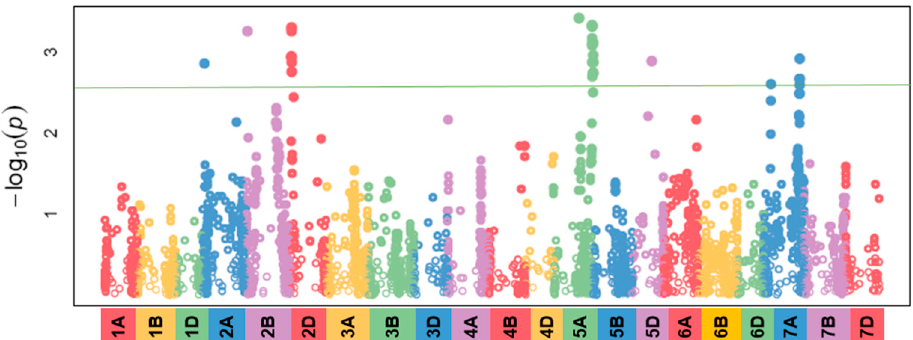
Figure 4. Manhattan plot, average area under the disease progress curve (AUDPC) values under greenhouse conditions, according to the chromosomal localization of the markers (level of significance: -log 10 ( p ) 2,5; Martonvásár, 2007, 2009).